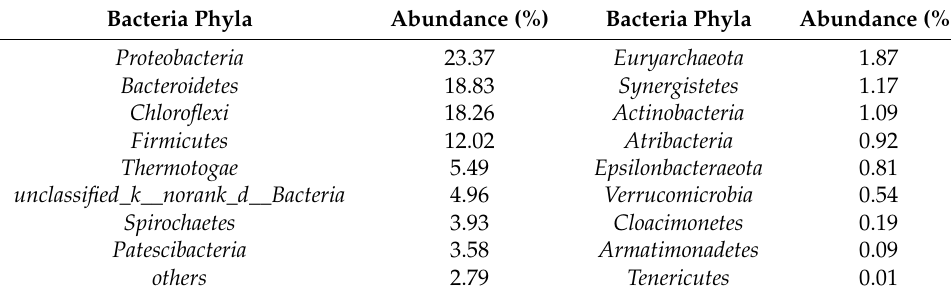
Table 3. The bacteria diversity of cake layer in phylum